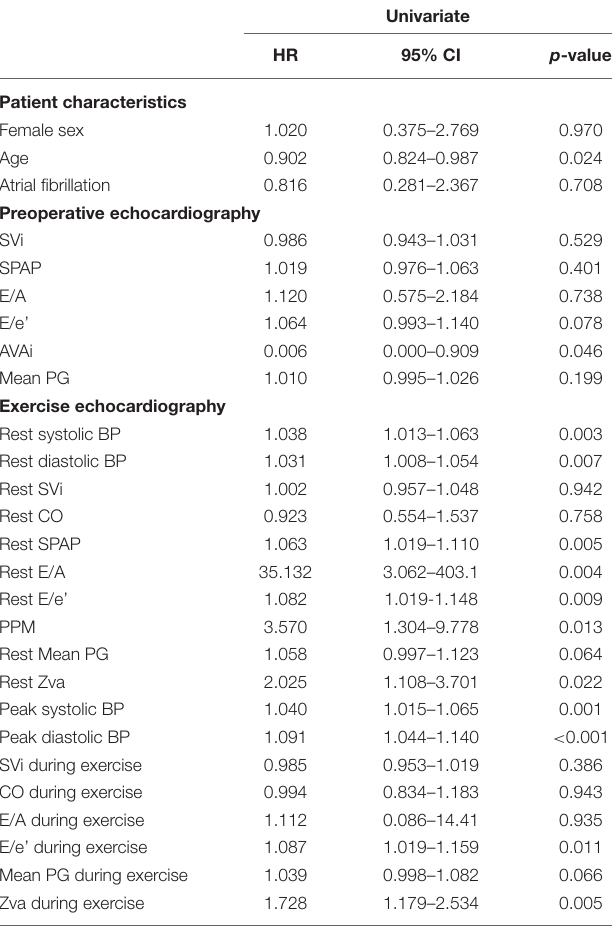
TABLE 5 | Univariate models of Cox regression analysis for exercise induced pulmonary